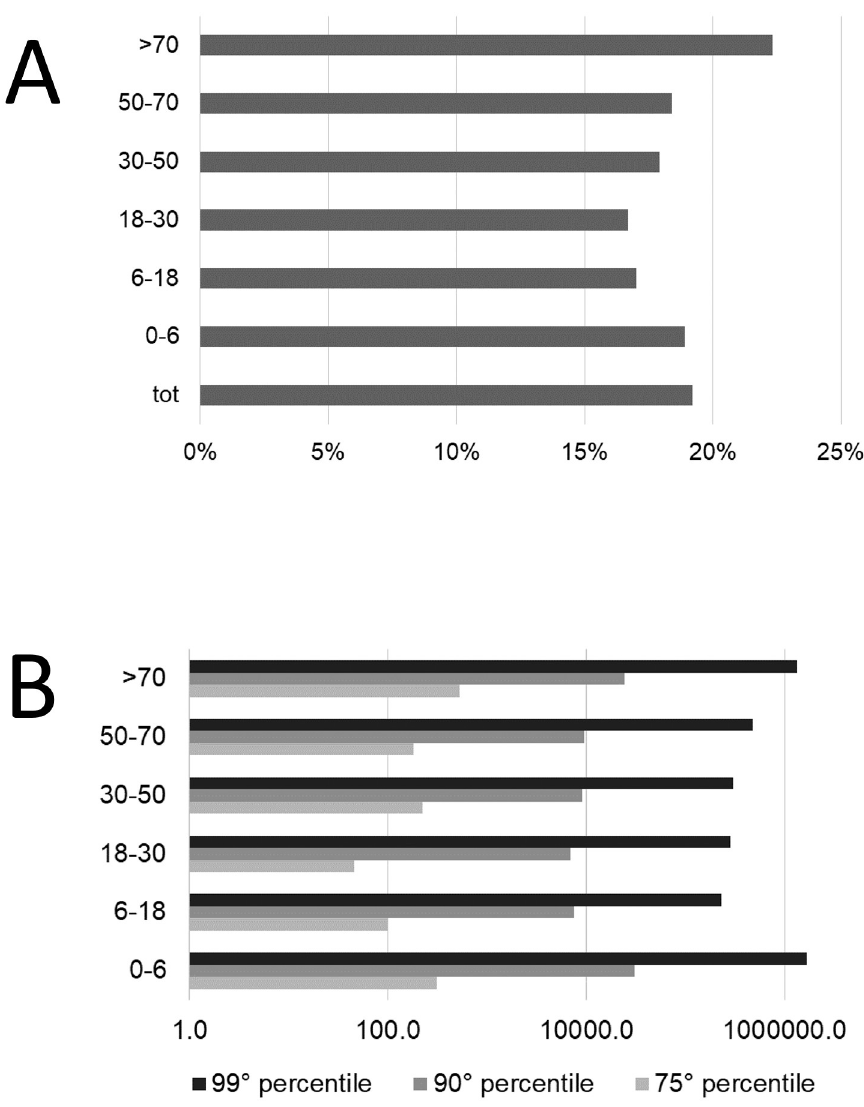
viral load divided by age